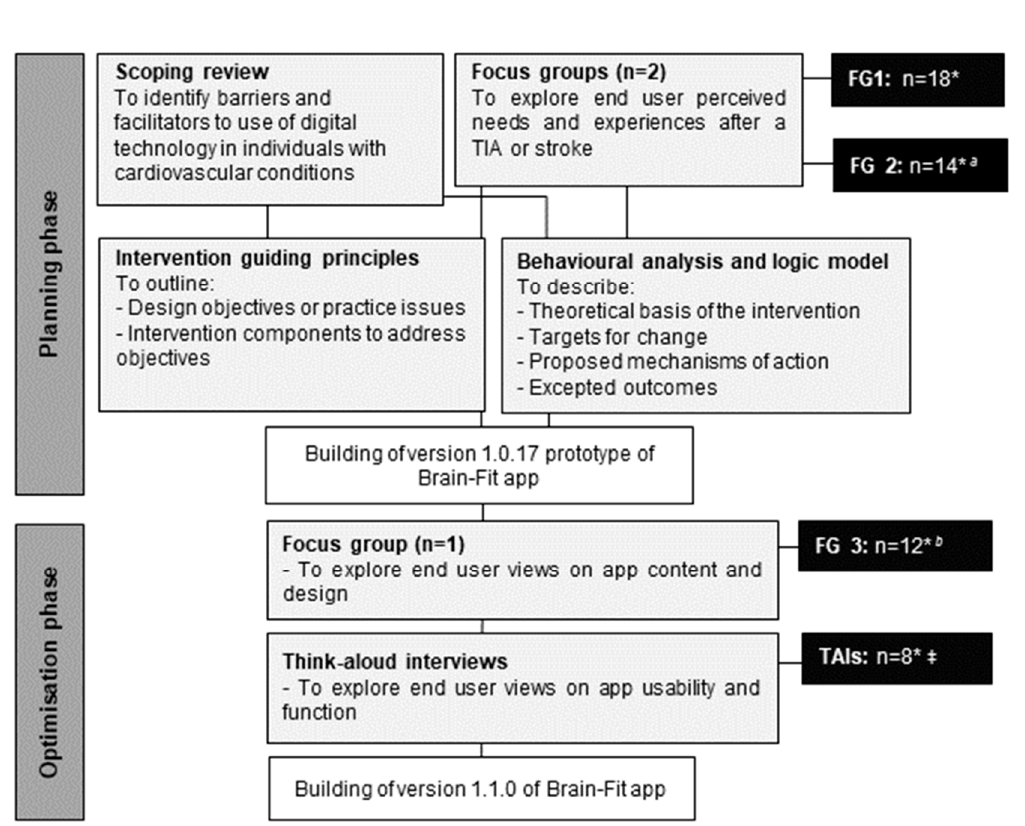
Figure 1. Stages in the process of developing the ‘Brain-Fit’ app. FG: focus group; TAIs: think-aloud interviews; * 32 participants took part in the study with some attending more than one focus group. Figures therefore reflect numbers attending at each step in the development process; a Of 14 participants at FG2, 5 had also attended FG1; b Of 12 participants at FG3, 7 had also attended FG1 or FG2; ‡ Participants in the think-aloud interviews had all taken part in one or more of the focus groups. Table 3. Demographic details of participants included in the study.